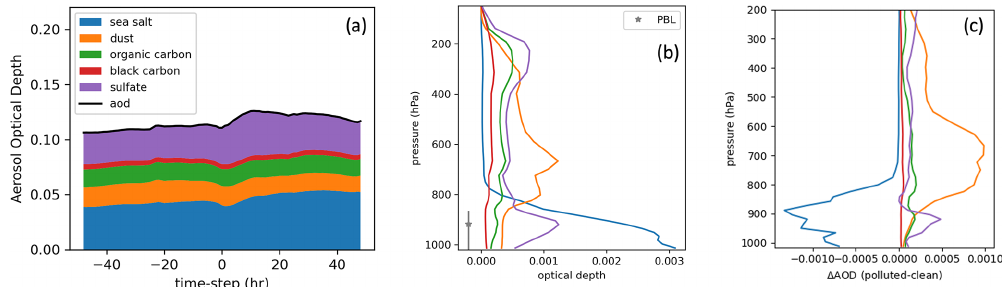
Figure 5. (a) Aerosol optical depth decomposed into sea salt (blue), dust (orange), organic matter (green), black carbon (red), and sulfate (purple) from MERRA-2 averaged along backward and forward trajectories over the period 21 June 2016–29 August 2020. (b) Vertical profile of the mean aerosol optical thickness for each species in each of the 72 pressure levels at the location of the ARM site at ENA. The average PBL height plotted over 2 standard deviations is provided along the y axis. (c) Change in AOD between polluted and clean trajectories based on above- and below-median CCN concentration measured from ARM.